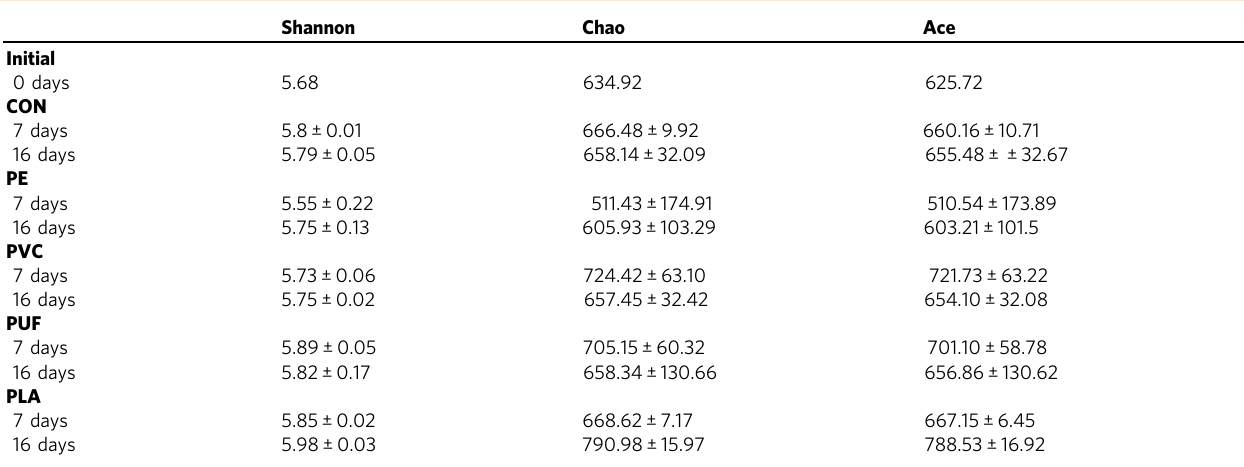
Table 1 Sediment community alpha